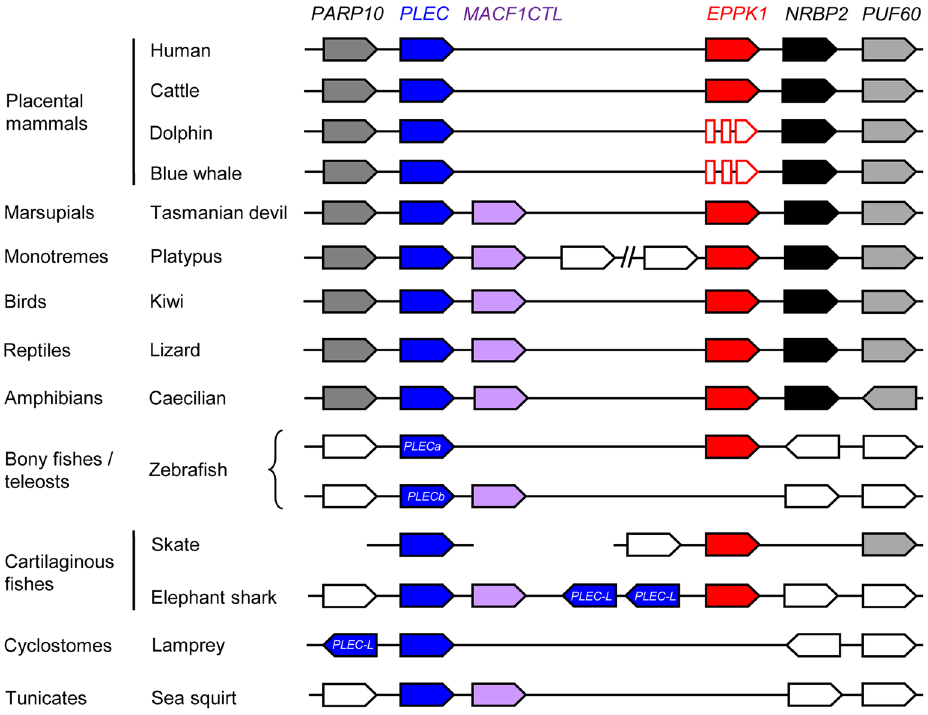
Figure 3. Comparison of PLEC and EPPK1 gene loci among chordates. Genes are schematically depicted by arrows pointing in the direction of transcription. Colors and grey shading mark orthologous genes of different species. White arrows represent genes that are not conserved across species. Disrupted arrows indicate the presence of inactivating mutations in the EPPK1 genes of cetaceans. The zebrafish has 2 PLEC genes (marked “a” and “b”) due a teleost-specific whole-genome duplication. The identity of several genes in basal chordates is uncertain. Details about the genes are provided in Supplementary Table S1. A break in the horizontal line indicates that not all genes located between MACF1CTL and EPPK1 of the platypus are shown. The PLEC gene of the skate is located on a genomic sequence scaffold not yet placed into the current genome assembly. Note that EPPK1 is present in jawed vertebrates (Gnathostomata) but not in lamprey (Cyclostomata) and sea squirt (Urochordata); Species: Human ( Homo sapiens ), cattle ( Bos taurus ), blue whale ( Balaenoptera musculus ), bottlenose dolphin ( Tursiops truncatus ), tasmanian devil ( Sarcophilus harrisii ), platypus ( Ornithorhynchus anatinus ), kiwi ( Apteryx rowi ), caecilian ( Rhinatrema bivittatum ), zebrafish ( Danio rerio ), skate ( Amblyraja radiata ), lamprey ( Petromyzon marinus ), sea squirt ( Ciona intestinalis ). Genes: EPPK1 , epiplakin 1; MACF1CTL , microtubule actin cross-linking factor 1 carboxy-terminus-like; PLEC , plectin; PLEC-L ,